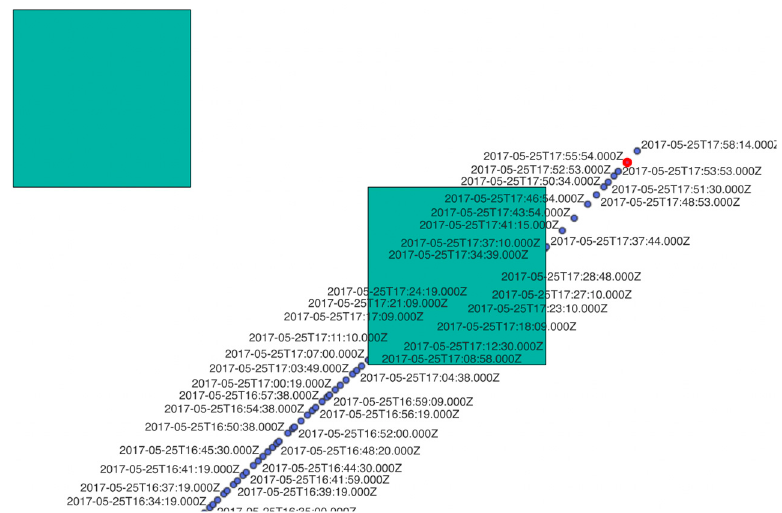
Figure 3. The output of SRP for ship 26, when using KNN-WD.